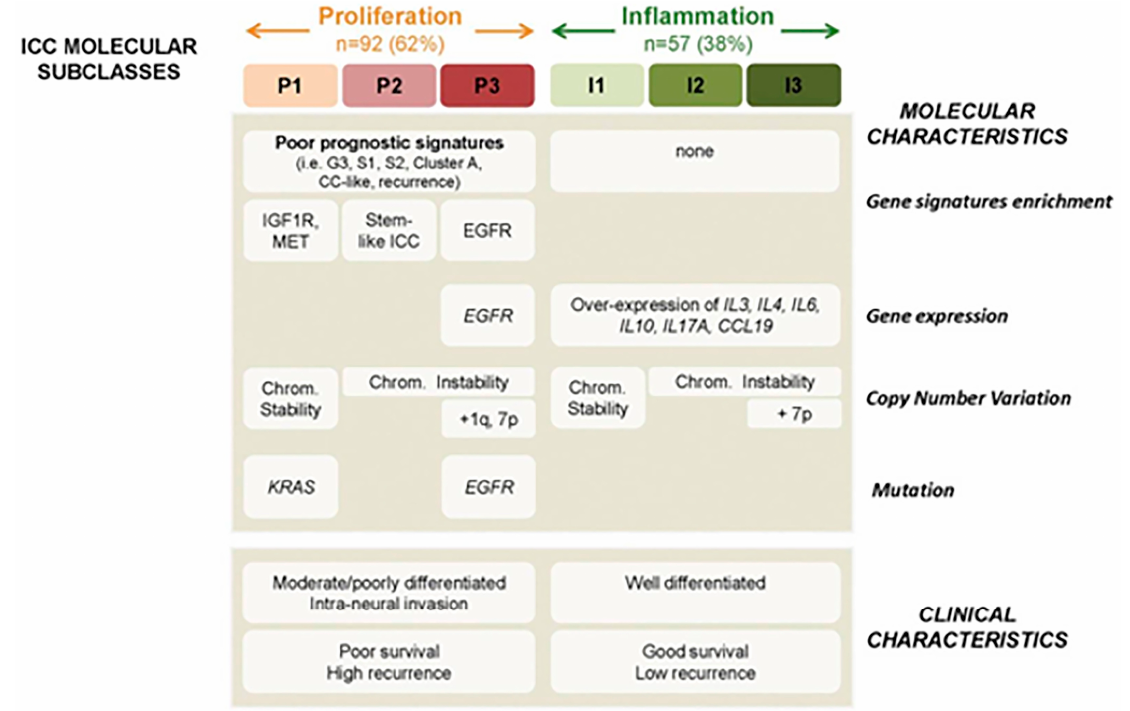
Figure 1. ICC Molecular Subclasses, reproduced from Sia et al. [32]. Summary of characteristics of ICC classes. Specific molecular and clinical characteristics differ between ICC classes. Molecular characteristics such as signatures of poor prognosis (i.e., cluster A, CC-like, G3, S1, S2, and stem-cell like ICC), oncogenic pathways (i.e., IGF1R, MET, EGFR), gene expression (i.e., EGFR , IL s), copy number variations, and oncogenes mutations ( KRAS and EGFR ) are differentially enriched in the proliferation and inflammation classes. Clinical characteristics such as moderate/poorly differentiated tumors and intraneural invasion are more frequent in the proliferation class. Differences in survival and recurrence were observed.